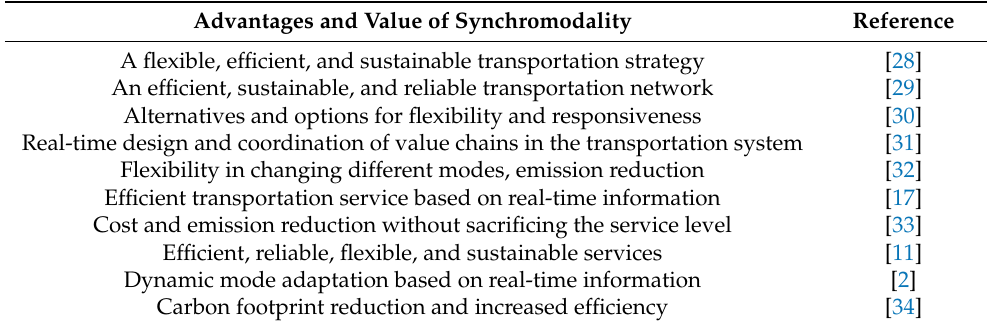
Table 2. Advantages of synchromodality and potential value it can